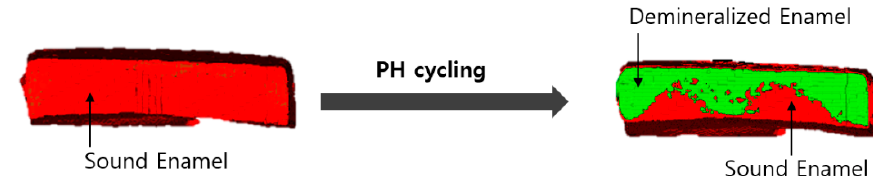
Children 2020 , 7 , x FOR PEER REVIEW Figure 3. Micro-CT images of sound enamel and enamel demineralized by pH cycling. Figure 3. Micro-CT images of sound enamel and enamel demineralized by pH cycling. Figure 3. Micro-CT images of sound enamel and enamel demineralized by pH cycling.